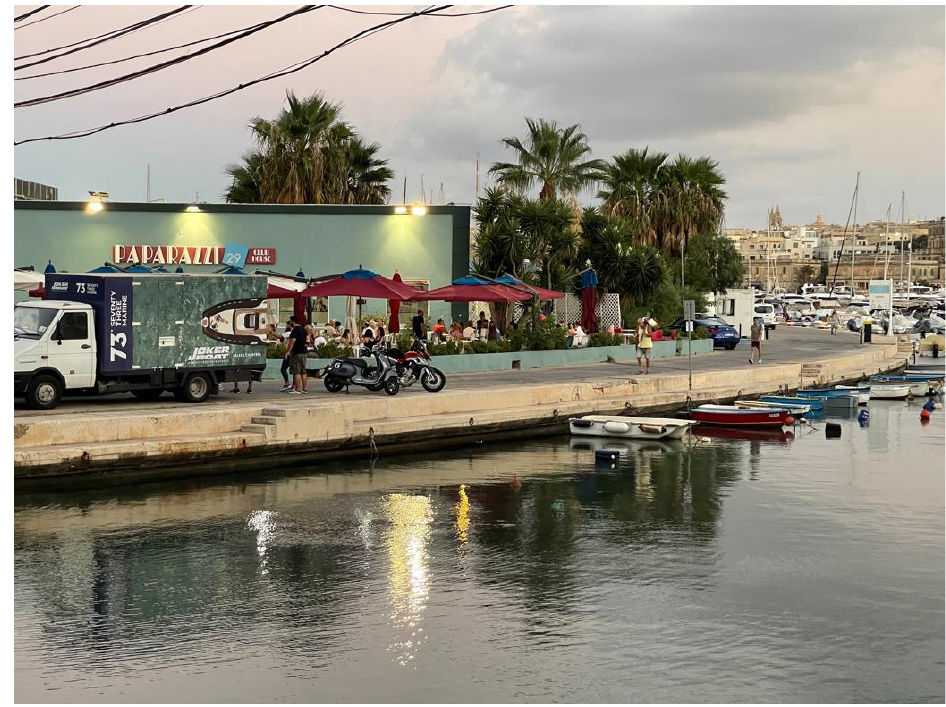
Figure 2. A Gżira business establishment located close to the water’s edge.